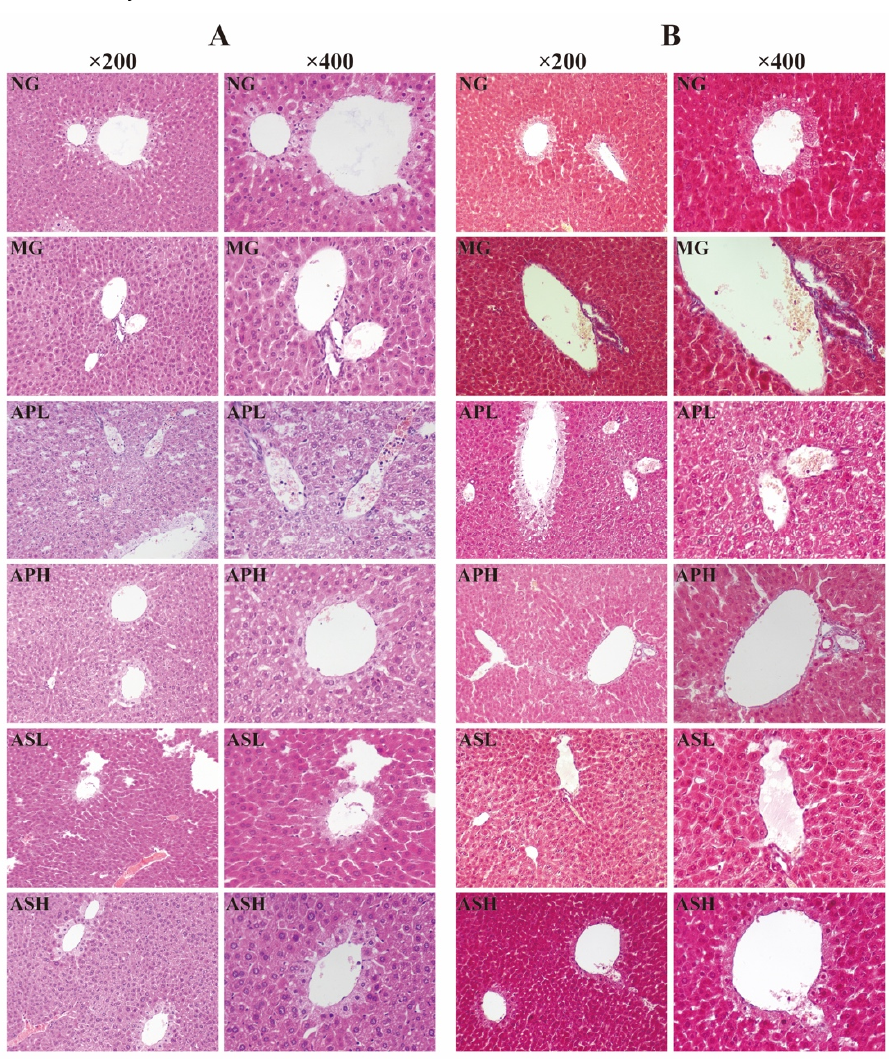
Figure 7. Histopathological detection of livers in ALD mice. ( A ) H&E staining in liver (×200 magni- fication and ×400 magnification); ( B ) Masson staining in liver (×200 magnification and ×400 magni-